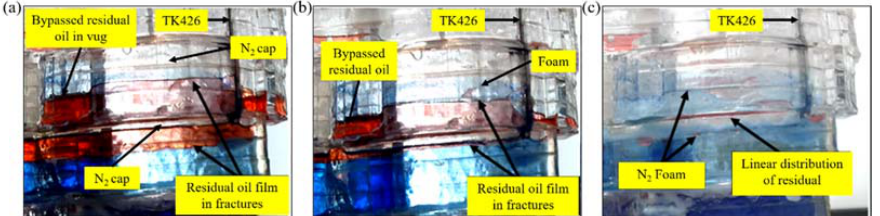
Figure 10. Mobilizing compound residual oil after water flooding in the fracture–vuggy unit controlled by well TK426: ( a ) Formation of various residual oil, ( b ) Mobilization of oil film and bypassed oil, ( c ) Formation of residual oil after foam-assisted nitrogen gas flooding.